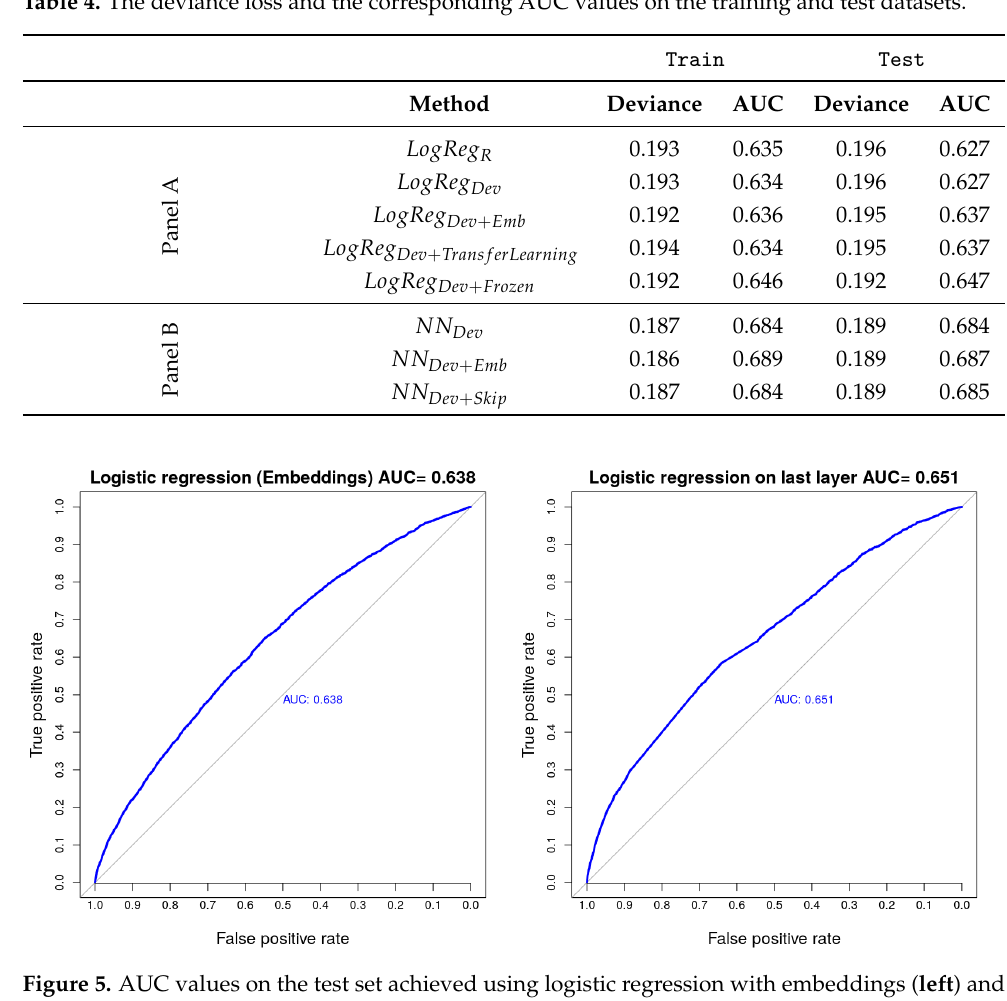
Table 4. The deviance loss and the corresponding AUC values on the training and test datasets.